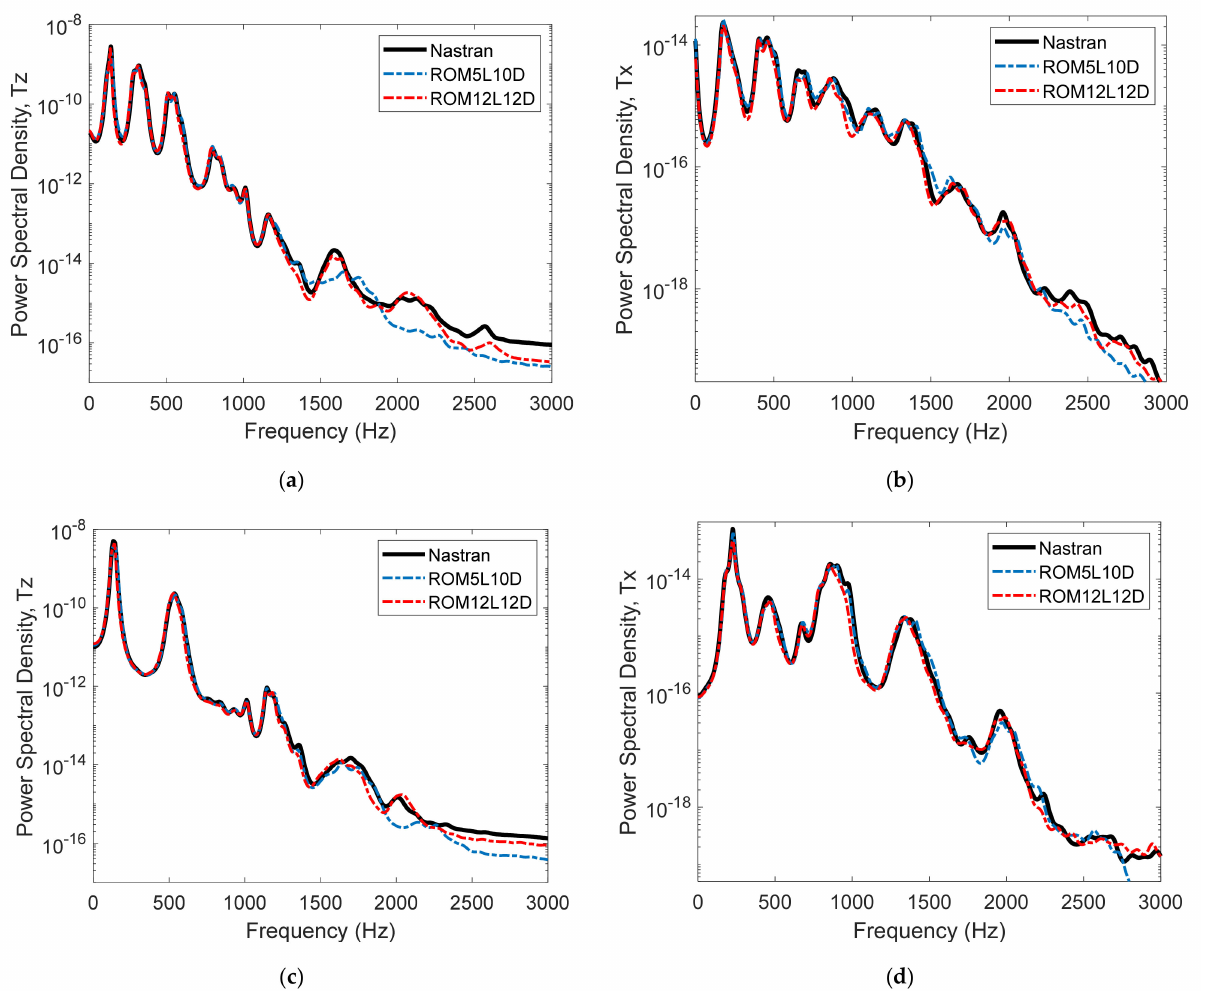
Figure 28. Power spectral densities of the responses predicted by Nastran and the 5L10D and 12L15D ROMs, quarter beam loading. ( a , b ) Quarter point, ( c , d ) middle point. ( a , c ) Transverse and ( b , d ) in-plane